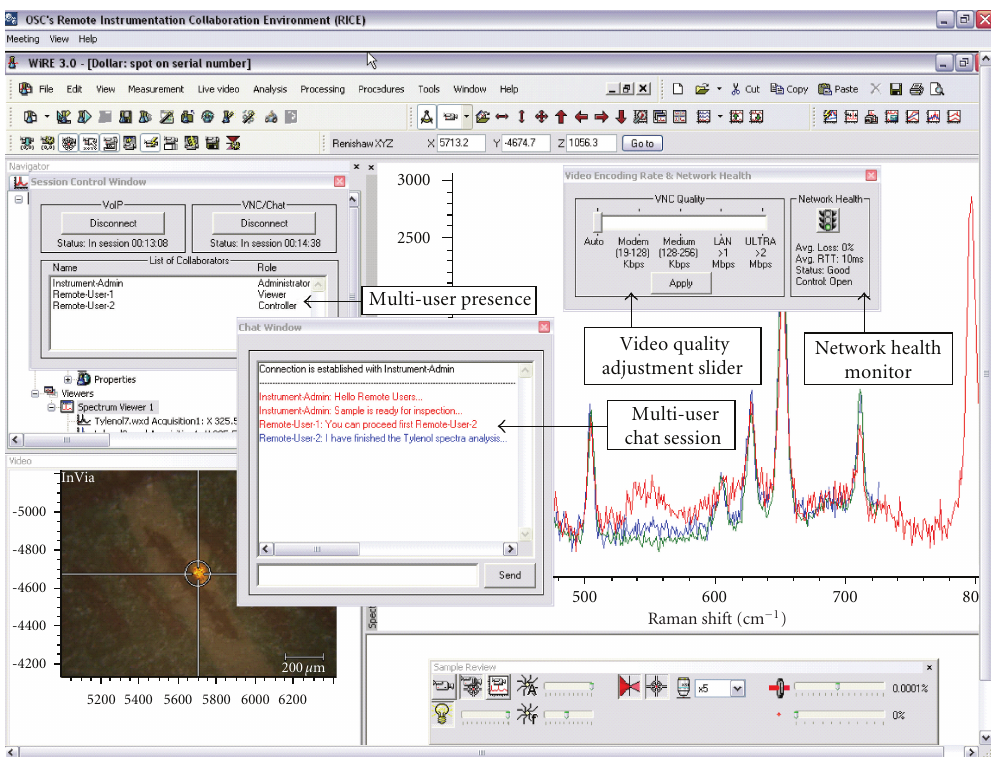
Figure 13: RICE in an active